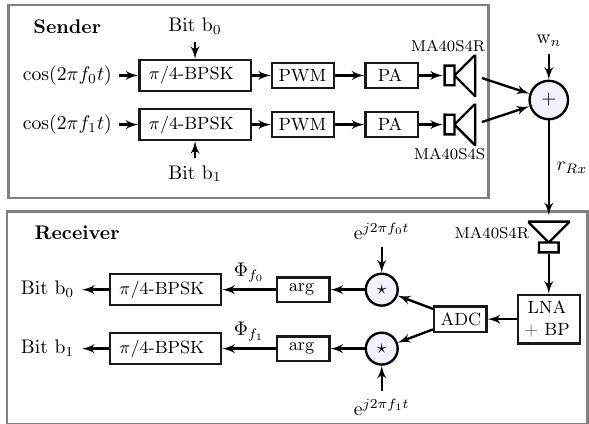
Figure 1. Schematic of the transmission system. The data bits ( b 0 and b 1 ) are mapped by π/ 4-BSK, modulated by pulse width modu- lation (PWM) to the analog signal and gained by the power ampli- fier (PA). The receiver transforms the ultrasound signal into electric values and calculates after the analog-to-digital conversion (ADC) with the folding operation ∗ the phase angle of the signal and the demapper estimates the data